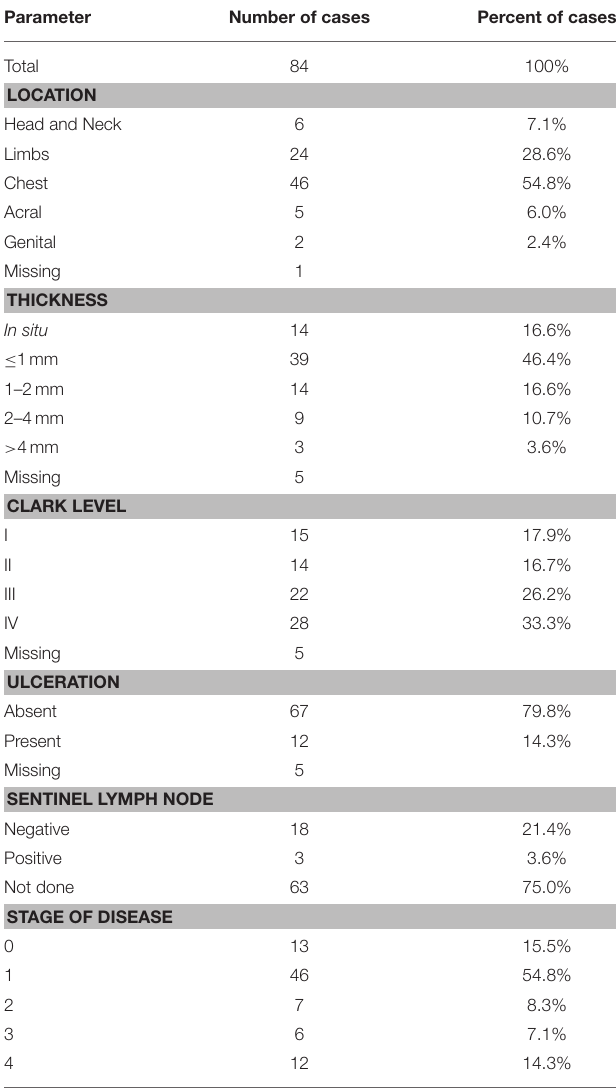
TABLE 1 | Clinicopathological characteristics of melanoma